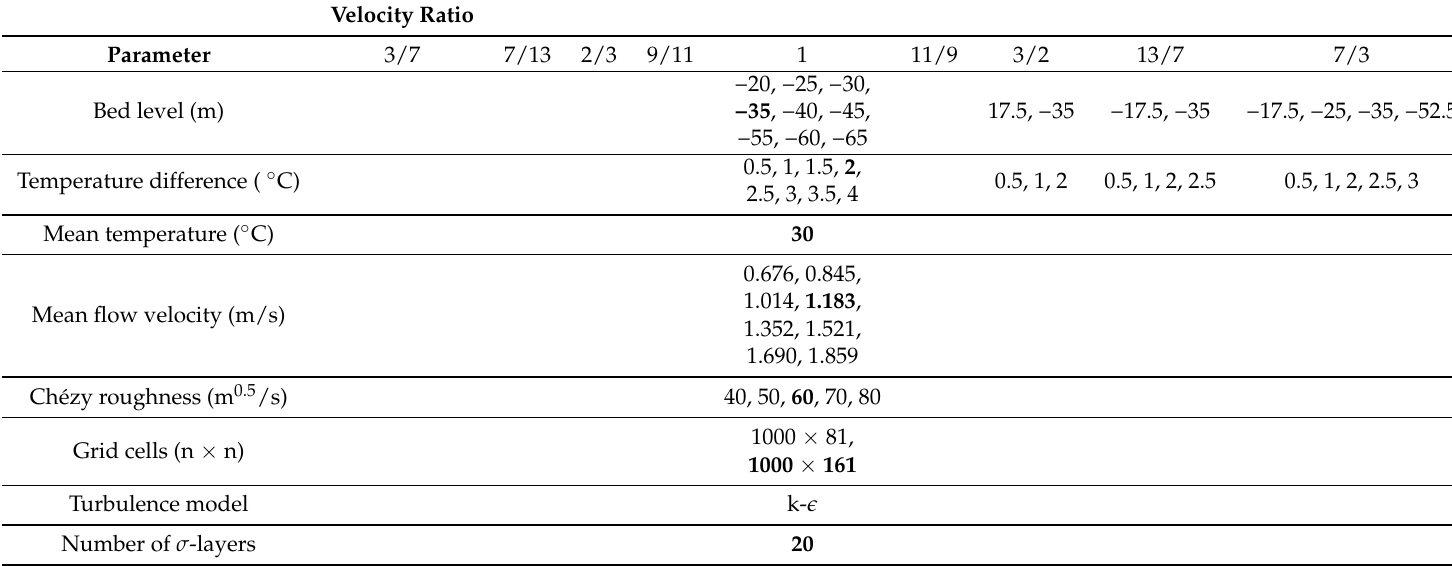
Table 1. Overview of the model runs and the parameter values used therein. The bold numbers relate to the basecase scenario and are the values used if no other value is